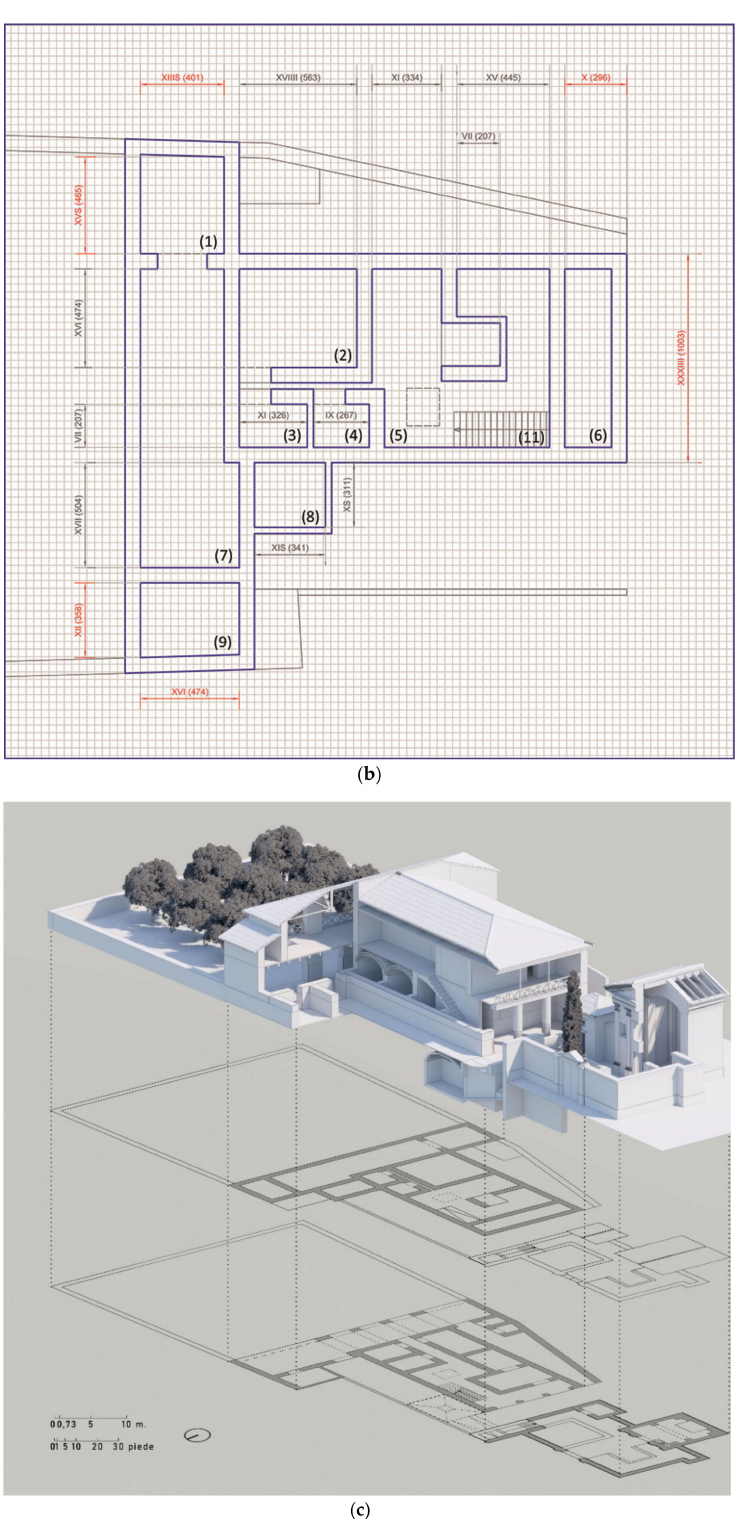
Figure 2. Vectorisation of the unified iconographies in the reduction scale. Comparison of the data obtained from the no-contact survey, from the analyses available in the literature, and from the calcu- lation of the annotated measurements in Roman figures. Hypothesis of the derived commensuration grids for the ground and the upper floor: ( a ) drawing and measurements of the lower floor; ( b ) drawing and measurements of the upper floor; and ( c ) comparison between the vectorisation done on the orthophoto and the reconstructed 3D model based on recalculated